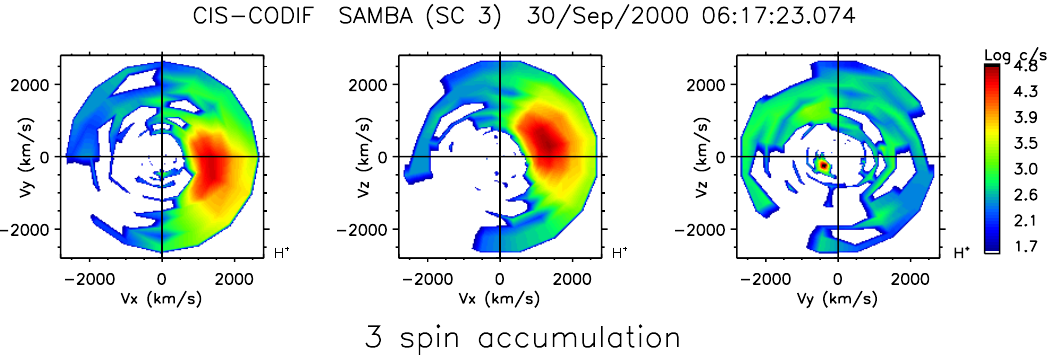
Fig. 26. CODIF H + distribution function (accumulation over 3 spins) in GSE coordinates on spacecraft 3 on 30 September 2000 at